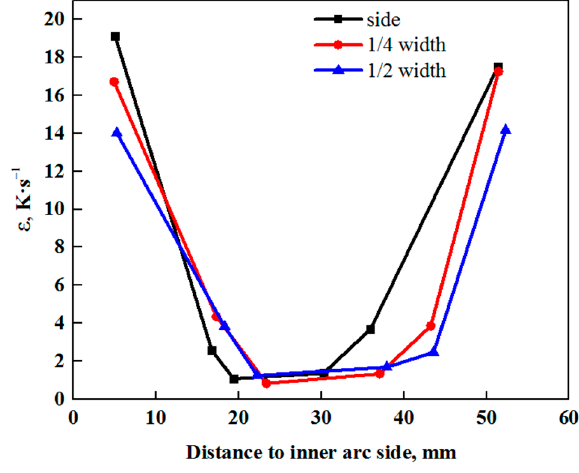
Figure 13. Results of cooling rate.